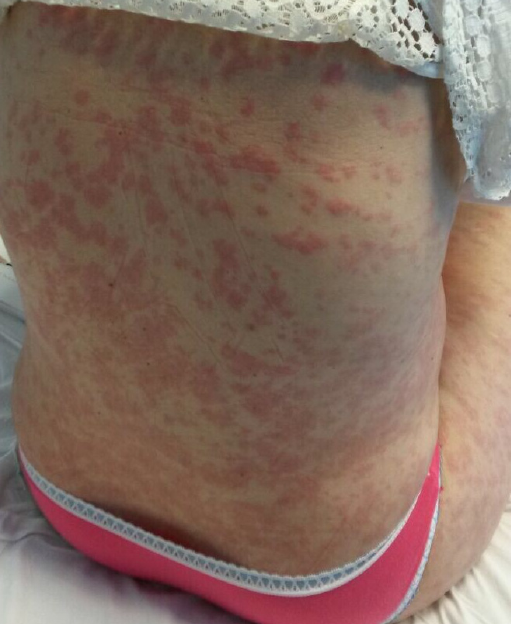
Figure 2. Erythematous papules and plaques on the trunk and inferior limbs. Lesions vary in size from 0.5 cm to large confluent areas.